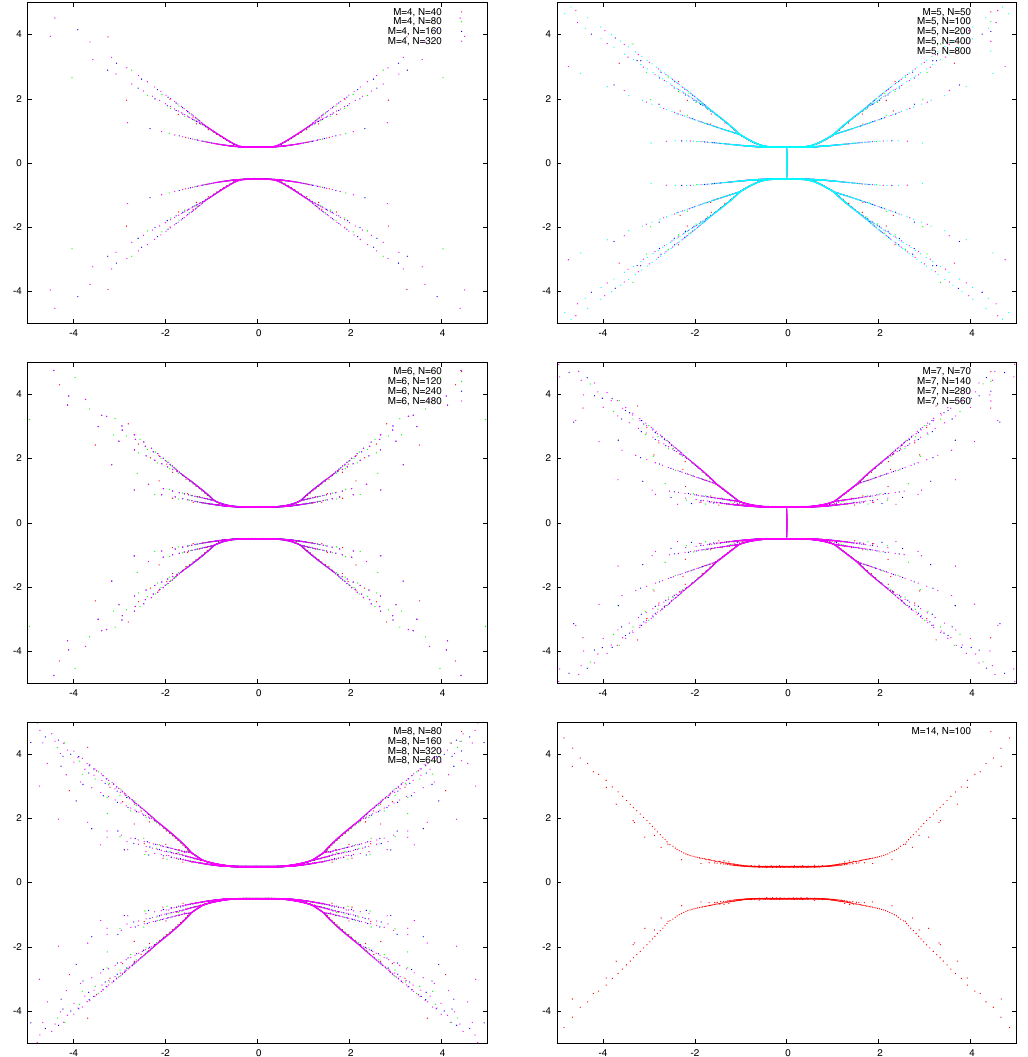
Figure 4 . Partition function zeros in the complex z -plane, shown in reading direction for M = 4 ; 5 ; (cid:1) (cid:1) (cid:1) ; 8 and M =